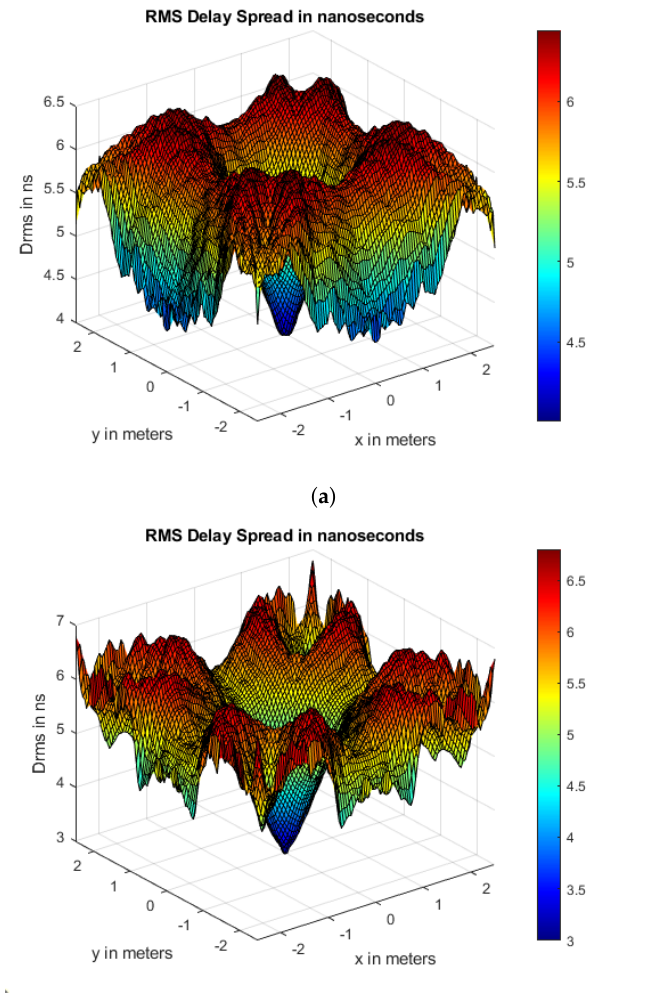
Figure 8. Root mean square (RMS) delay spread distribution for ( a ) CLQ and ( b ) CoIQ-9. (c) Effects of Varying Body Postures under Low-Lighting